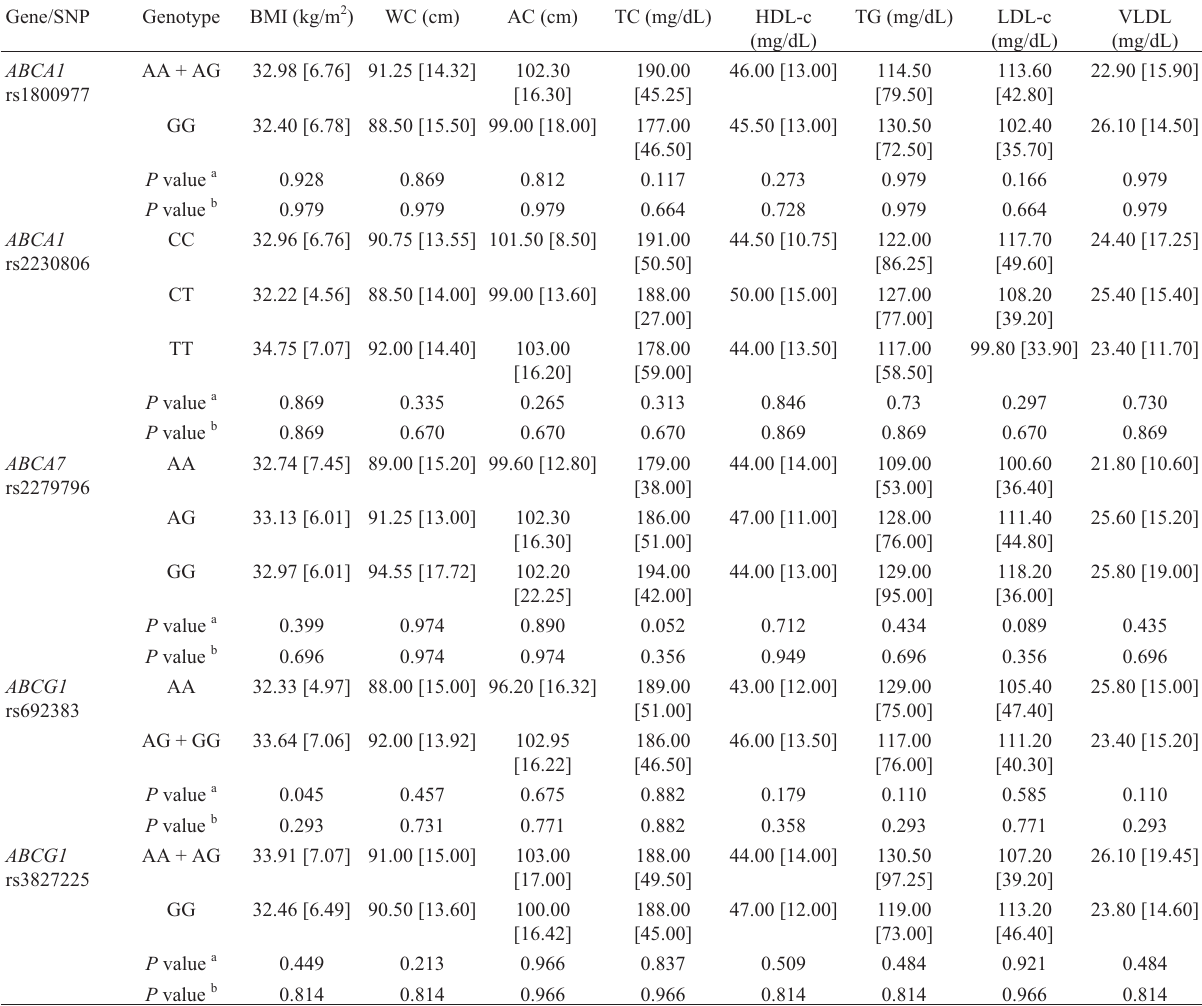
Table 4 - After dietary intervention characteristics (median [IQR]) according to the ABCA1 , ABCA7 and ABCG1 genotypes. Gene/SNP